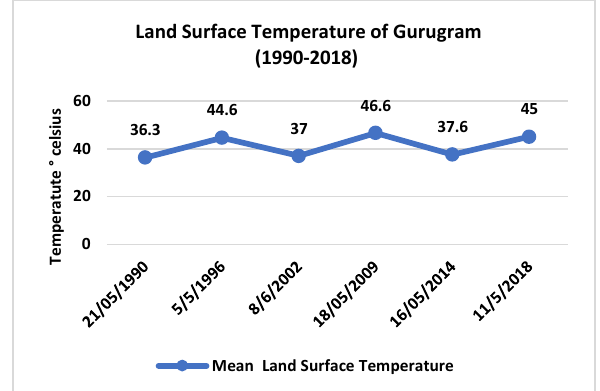
Figure 13. Temporal Land Surface Temperature